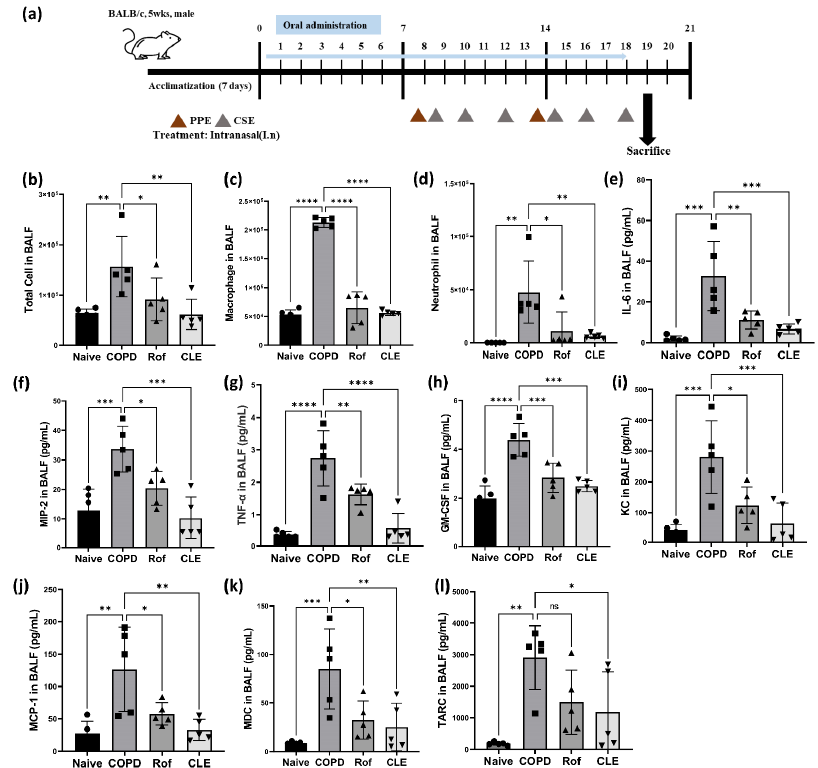
Figure 1. Effect of the CLE on the inflammatory cell count, cytokines and chemokines in BALF from the PPE- and CSE-induced COPD model. ( a ) The timeline of mouse PPE and CSE sensitization and oral administration. ( b – d ) Total cell, macrophages and neutrophils numbers in BALF following PPE and CSE treatment. ( n = 5) ( e – l ) BALF levels of IL-6, MIP-2, TNF- α , GM-CSF, KC, MCP-1, MDC and TARC were analyzed by Q-plex assay kit. ( n = 5) Data were analyzed by one-way ANOVA by Dun- nett’s test. All values are reported as mean SD. * p < 0.05, ** p < 0.01, *** p < 0.001, **** p < 0.0001. Naïve (Circle): vehicle control, COPD (Square): PPE/CSE treatment, ROF (Triangle): roflumilast (10 mg/kg) + PPE/CSE treatment, CLE (Inverted triangle): Camelia sinensis ethanol extract (200 mg/kg) + PPE/CSE treatment. CLE: Camellia sinensis L. extract, PPE: Porcine pancreas elastase, CSE: Cigarette smoke extract, COPD: Chronic obstructive pulmonary disease, IL-6: Interleukin 6, MIP-2: Macro- phage inflammatory protein-2, TNF- α : Tumor necrosis factor- α , GM-CSF: Granulocyte–macro- phage colony-stimulating factor, KC: Keratinocyte-derived chemokine, MCP-1: Monocyte chemo- attractant protein-1, MDC: Macrophage-derived chemokine, and TARC: Thymus- and activation- regulated chemokine.